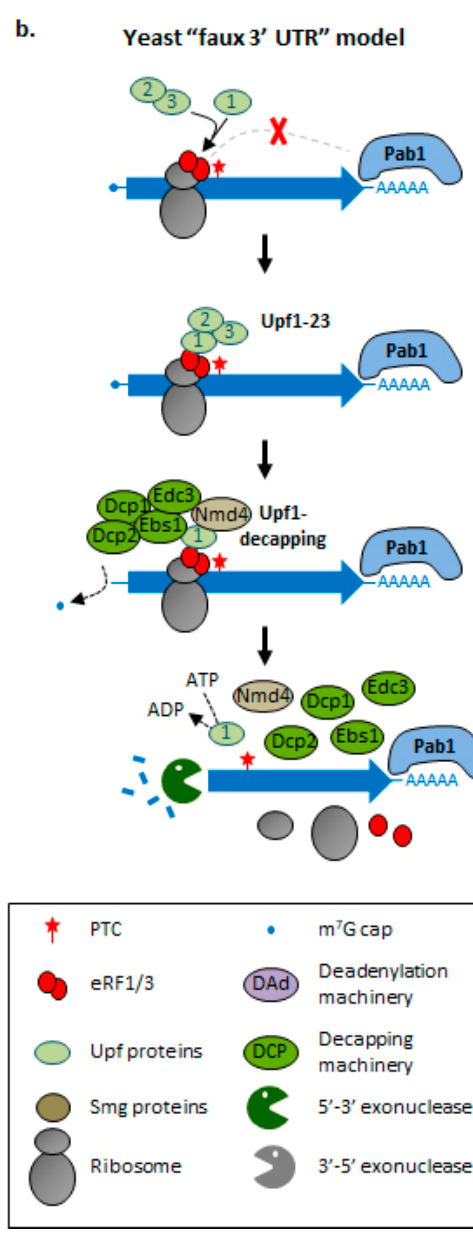
Figure 1. Models of NMD activation mechanisms in mammals and yeast. ( a ) Mammalian EJC-enhanced NMD. When an EJC remains bound to the RNA downstream of a termination codon, translation termination is inefficient as the EJC interferes with the interaction between PABPC1 and the eukaryotic release factors (eRF1/eRF3). Instead, a SURF complex (Smg1–Upf1–eRF1–eRF3) forms at the level of the PTC. Upf2 and Upf3 are then recruited by the downstream EJC and associate with SURF to form the decay-inducing (DECID) complex. Smg1 phosphorylates Upf1 (P), activating it. Phosphorylated Upf1 promotes RNA decay via Smg6-dependent endonucleolytic cleavage and the Smg5–Smg7-dependent triggering of mRNA deadenylation and decapping. ATP hydrolysis by Upf1 allows the dissociation of the termination complex and the release of the transcript, which can be degraded. Upf1 dephosphorylation by protein phosphatase 2A (PP2A) allows it to return to a dephosphorylated state. The coding region and the UTRs of the mRNA are represented as a large blue arrow and thin blue lines, respectively. See the key for the other symbols. ( b ) “Faux” 3 ′ UTR model in yeast. A long 3 ′ UTR results in inefficient translation termination and Upf1 interaction with eRF1/eRF3, promoting the formation of the Upf1-23 complex (Upf1, Upf2, Upf3) at the level of the terminating ribosome. The Upf2-Upf3 heterodimer is then replaced by Nmd4, Ebs1, the decapping enzyme Dcp2 and its co-factors Dcp1 and Edc3 in the Upf1-decapping complex, leading to RNA decapping. ATP hydrolysis by Upf1 promotes the disassembly of the mRNA/ribosome/Upf1-decapping complex, leading to the release of the transcript which can finally be degraded by